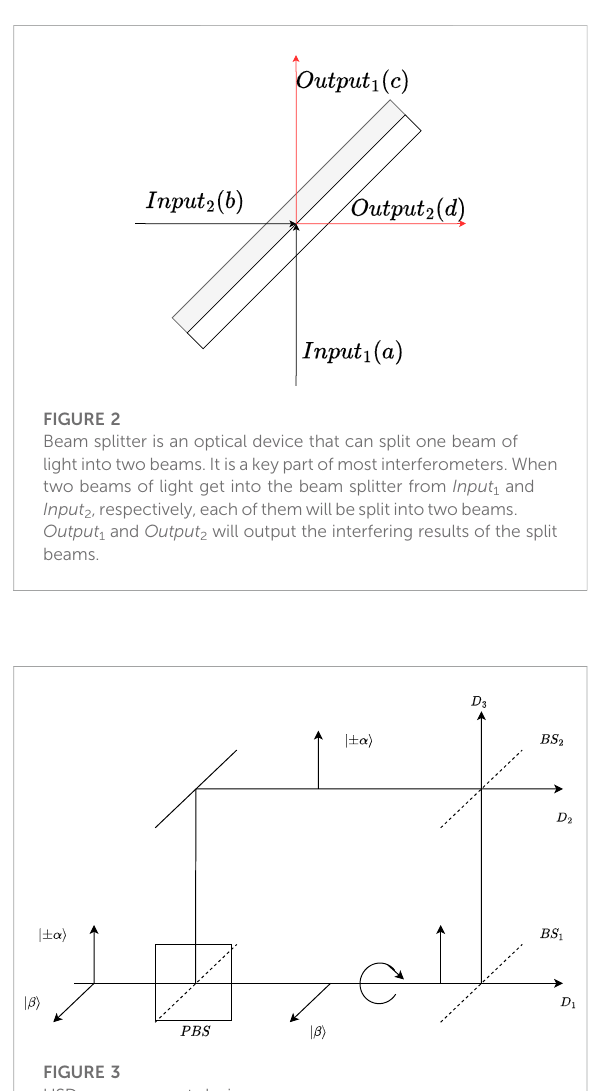
FIGURE 3 USD measurement